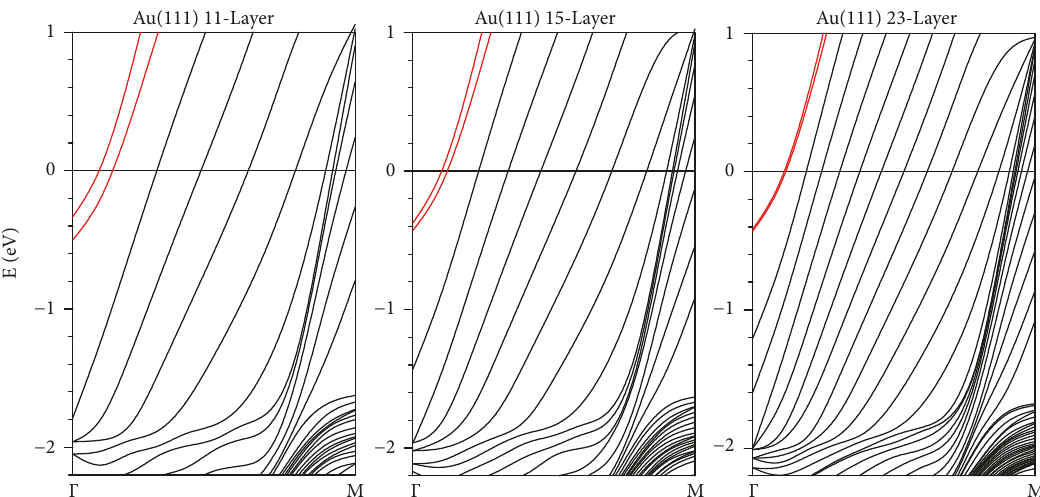
Figure 2: The band structure of Au(111) calculated for various thicknesses of films in semirelativistic